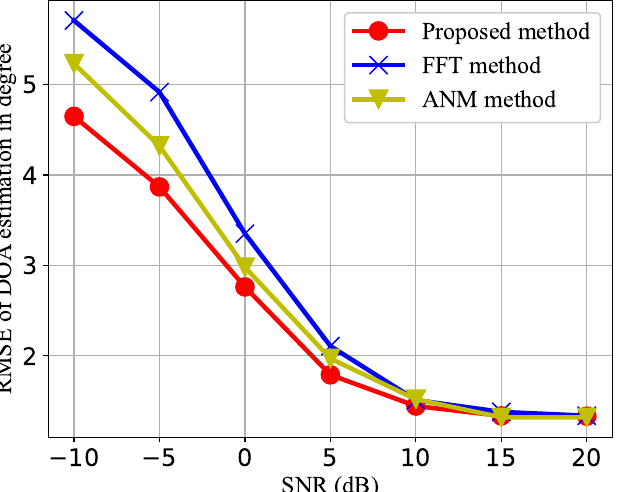
Figure 16. The RMSE of the DOA estimation using 2-bit ADC to show the performance of the proposed